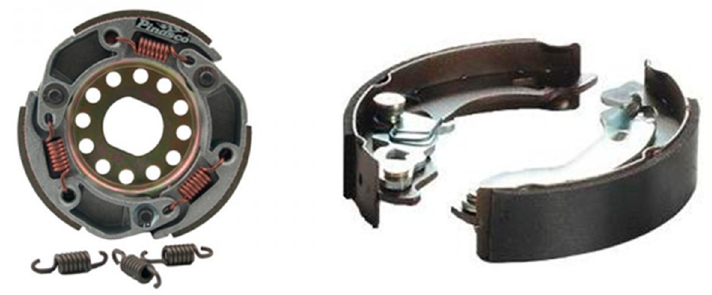
Figure 3. Expansion clutch and mechanical brake.